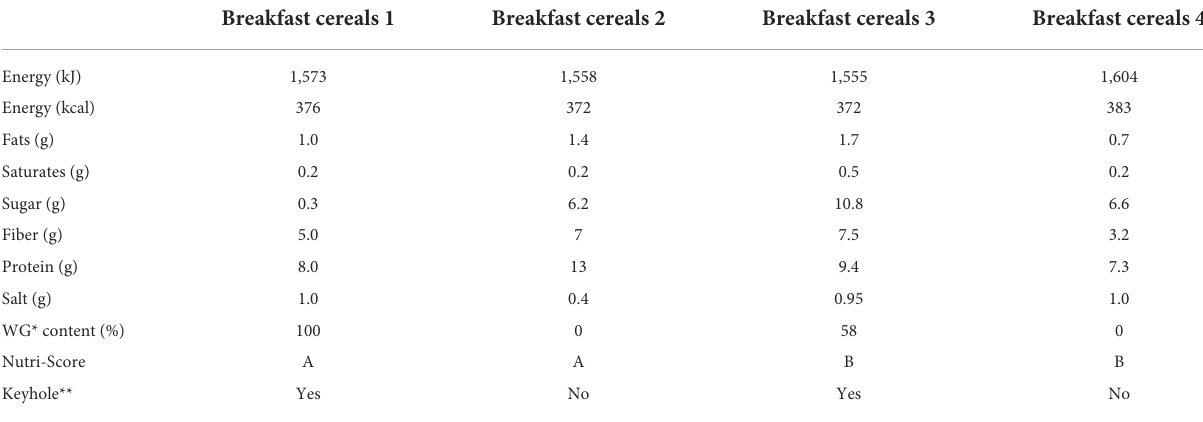
TABLE 3 Energy and nutrient content per 100g of breakfast cereals sold on the Italian market and selected for having different calculated Nutri-Score and for having or not Keyhole. Breakfast cereals 1 Breakfast cereals